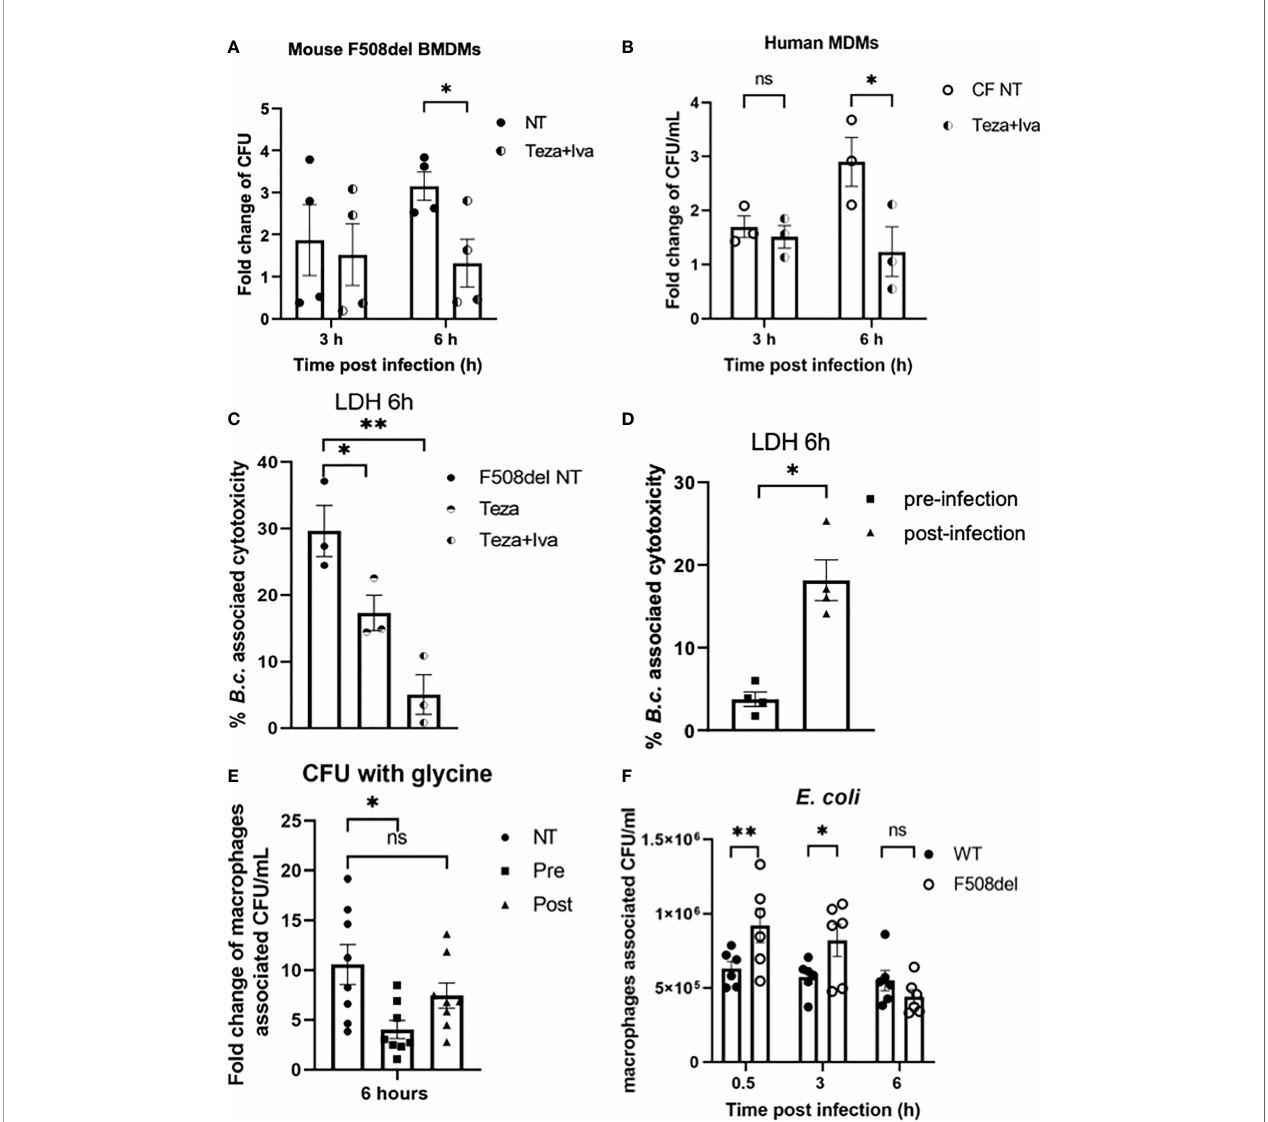
FIGURE 7 | CFTR modulators reduce Burkholderia cenocepacia burden in cystic fi brosis (CF) macrophages and decrease bacteria-associated cell death. (A) Fold change of B. c. intracellular survival in mouse F508del macrophages treated with Teza+Iva for 24 h prior to infection for 3 and 6 h. Fold change was calculated relative to 0.5-h time point (invasion). Data represent mean ± SEM (n = 5 biological replicates). Statistical analysis was performed using two-way ANOVA; *, p ≤ 0.05. (B) Fold change of B. c. intracellular survival in human CF F508del/F508del monocyte-derived macrophages (MDMs) either non-infected (NT) or treated with Teza+Iva for 24 h. Fold change was calculated relative to 0.5-h time point (invasion). Data represent mean ± SEM (n = 3 biological replicates). Statistical analysis was performed using two-way ANOVA; *, p ≤ 0.05; ns, non-signi fi cant. (C) Lactate dehydrogenase (LDH) release at 6 h from B.c. -infected mouse F508del macrophages either NT or treated with Teza − /+Iva for 24 h prior to their infection. Data represent mean ± SEM (n = 3 biological replicates). Statistical analysis was performed using two-way ANOVA; *, p ≤ 0.05; **, p ≤ 0.01. (D) LDH release at 6 h from B.c. -infected mouse F508del macrophages, treated with Teza+Iva either prior to (pre-infection) or after infection (post-infection). Data represent mean ± SEM (n = 4 biological replicates). Statistical analysis was performed using two-way ANOVA; *, p ≤ 0.05. (E) Fold change of intracellular survival of B. c. in mouse F508del macrophages at 6 h of infection that were NT, pre-, or post-infection treated with Teza+Iva. Fold change was calculated relative to 0.5-h time point (invasion). Data represent mean ± SEM (n = 4 biological replicates). Statistical analysis was performed using two-way ANOVA; *, p ≤ 0.05; ns, non-signi fi cant. (F) Intracellular survival of Escherichia coli in wild-type (WT) and F508del macrophages at 0.5, 3, and 6 h of infection. Data represent mean ± SEM (n = 3 biological replicates). Statistical analysis was done by two-way ANOVA; * p ≤ 0.05; ** p ≤ 0.01; ns, non-signi fi